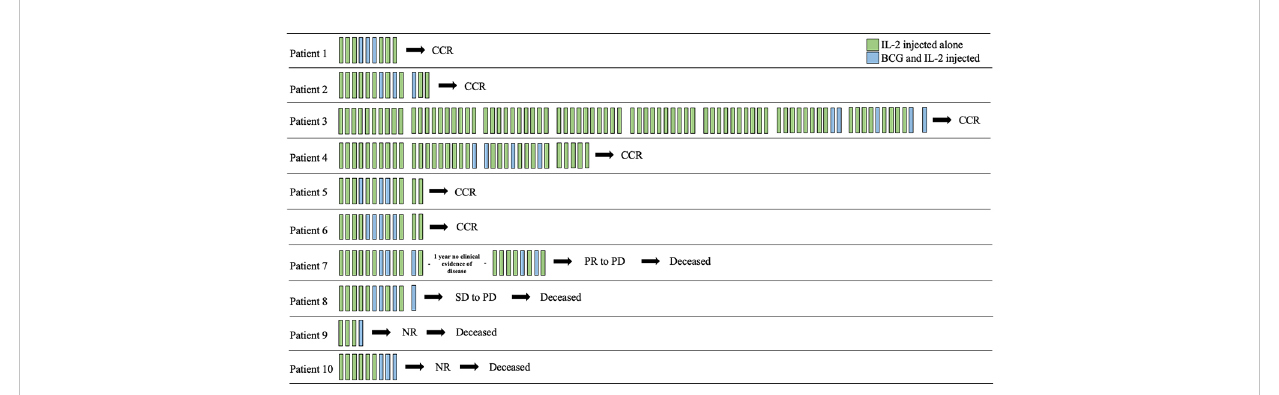
FIGURE 1 Timeline of intralesional IL2 and BCG treatments. Each bar represents a two-week period and are grouped in tens (where applicable) for ease of viewing. iIL2 treatments occur every two weeks (green bars), while BCG was added after partial response to iIL2 every 2-4 weeks for 1-4 treatments. CCR, complete clinical response; PR, partial response; PD, progressive disease; SD, stable disease; NR, no